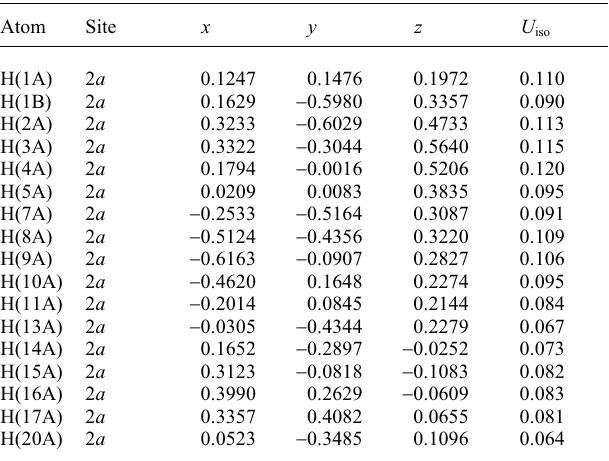
Table 2. Atomic coordinates and displacement parameters (in Å 2 )